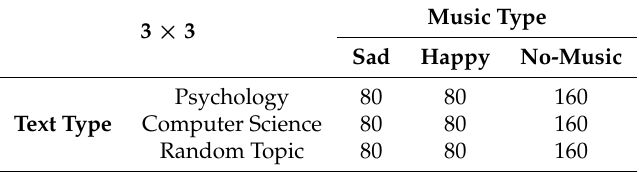
Table 1. Experimental Design: Experimental and Control Conditions with a Total Sample